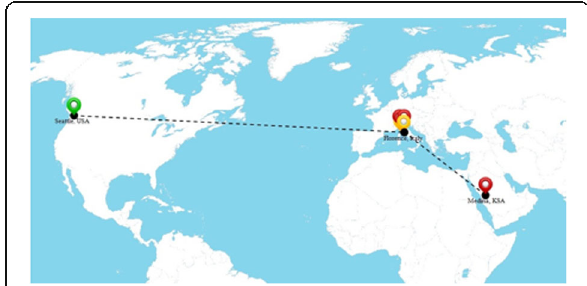
Fig. 5 Geographic Distribution of the Remote Cloud, Cloudlets and